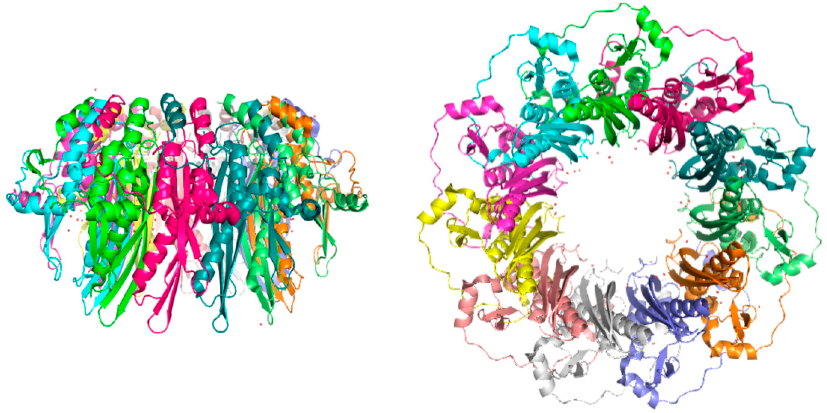
9 of 28 Figure 4. Multiple alignments of RAD52 sequences. ( a ) Alignment of N-terminal and ( b ) C-terminal domain sequences of different organisms. In contrast to the N-terminal domain, the C-terminal domain is not conserved. Low-resolution evidence from electron microscopy studies on full-length RAD52 (RA52 FL) [52–54] suggests that RAD52 forms heptameric rings. Noteworthy, the same group recently published a cryogenic electron microscopy (cryo-EM) structure of RAD52 FL, showing that the full-length protein can oligomerize as an undecamer, suggesting a new hypothesis for the oligomerization state of RAD52 FL, in contrast to what was previously speculated [55]. RAD52 FL rings have a tendency to form even higher molecular weight (MW) superstructures that interact with other protein functional units in a stacked- or side-by- side fashion. The tendency to form such high-MW superstructures is increased in the presence of DNA [49,51,56,57]. X-ray crystal structures, available for the N-terminal portion of RAD52 (i.e., AA 1–212 or 1–209) (PDB 1H2I, 1KN0, 5JRB, 5XRZ, and 5XS0), have allowed the protein’s DNA-binding and multimerization domains to be characterized [49,58–60]. The crystal structure of RAD52 ′ s N-terminal domain shows a ring-shaped undecamer, resembling a mushroom, with a “stem” and a “domed cap” (Figure 5). The stem of each monomer has a β - β - β - α structure, in which the upper parts of the β -strands of all the monomers align side by side, forming the inner part of the channel. The domed